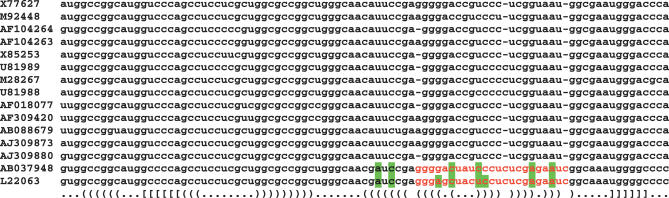
Clustal-X Alignment for the HDV Dataset Consisting of 15 Sequences of HDV RibozymesSome parts of the AB037948 and L22063 sequences are misaligned (red characters), which causes nonsense base-pairs (highlighted in green) when mapping the known reference structure onto these sequences.